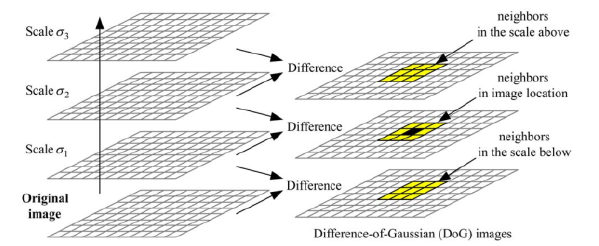
Figure 2. Difference-of-Gaussians (DoG) function and neighbors of a pixel